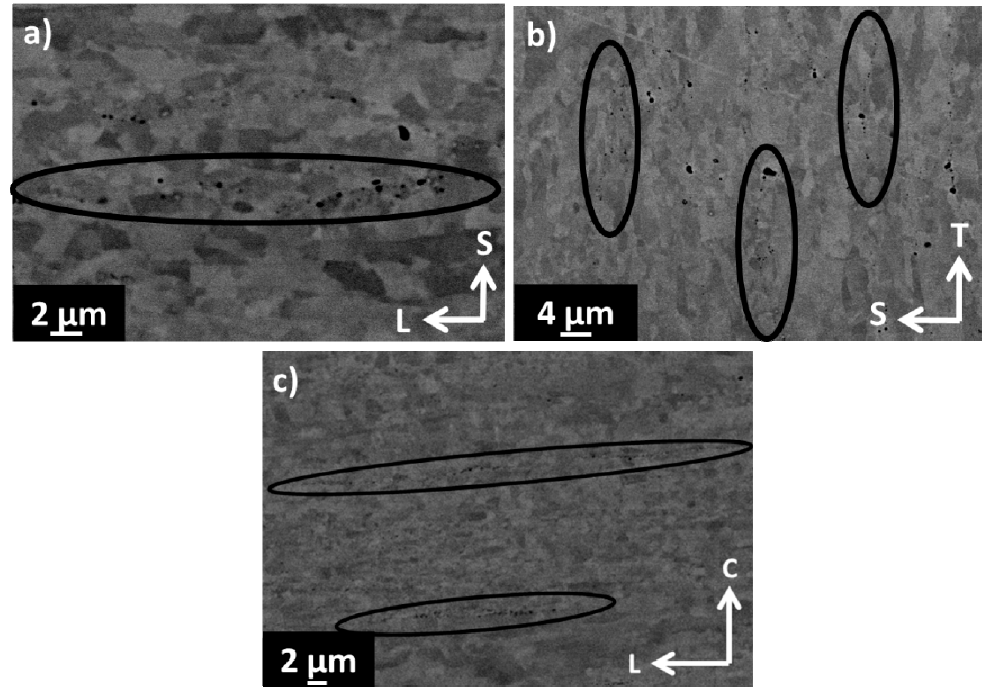
Figure 3. Backscattered SEM images of OP-S polished surface showing aligned holes (encircled) formed after Ti-enriched particle fall out in ODS-KIT HR in the ( a ) LS plane and in the ( b ) TS plane together with the ( c ) longitudinal plane of ODS-KIT HE showing arranged Ti particle fall out in the longitudinal direction.